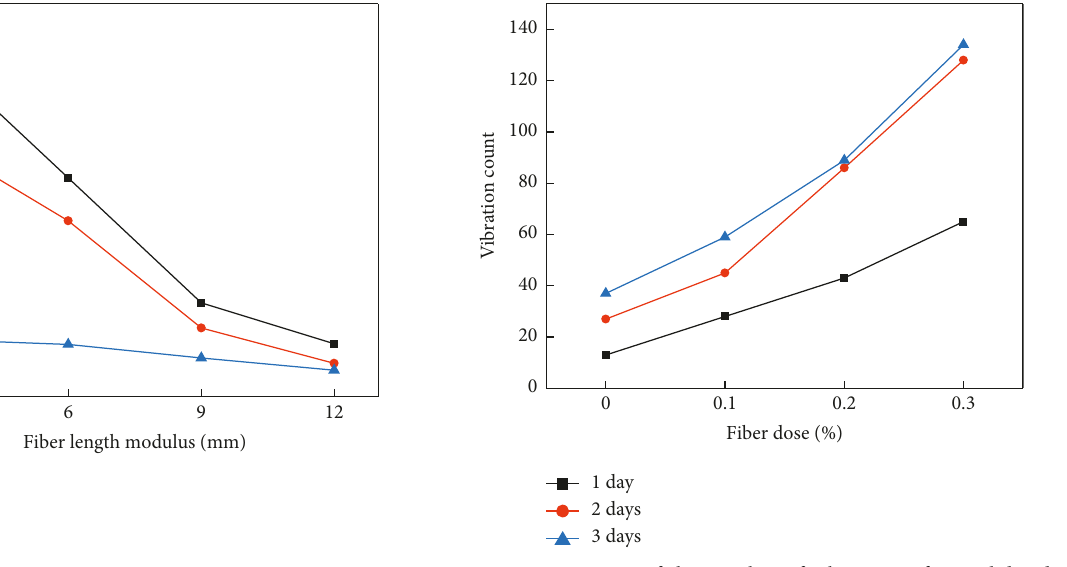
Figure 6: Diagram of variation of internal friction angle of remolded soil with fiber length modulus at different conservation ages.